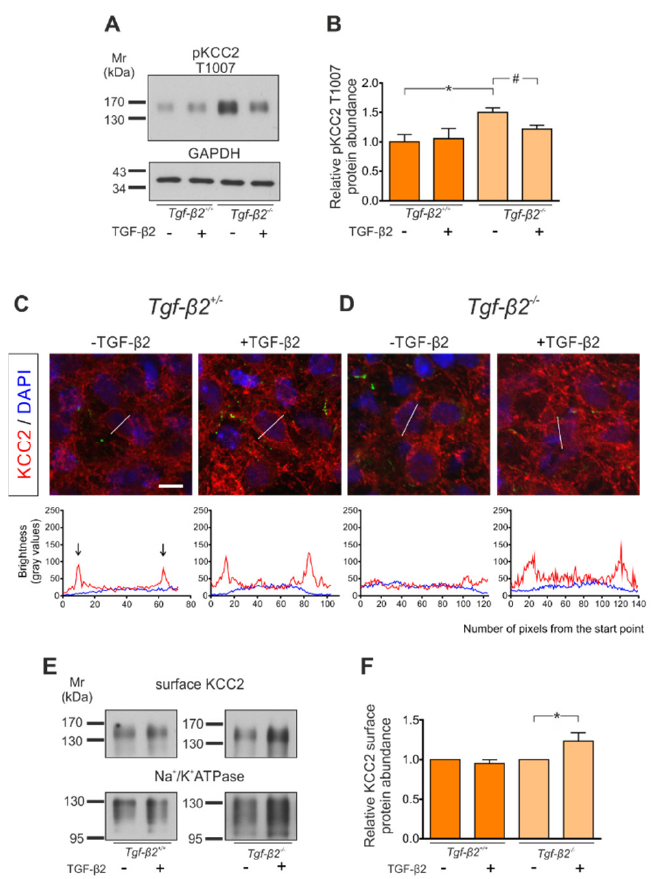
Figure 7. Application of exogenous recombinant TGF-β2 regulates phosphorylation and membrane expression of KCC2 in brainstem of Tgf-β2 −/− mutants. Acute slices from preBötC complex of E17.5–E18.5 from wildtype ( Tgf-β2 +/+ or Tgf-β2 +/− ) and Tgf-β2 −/− mutants were cultured in the presence or absence of recombinant human TGF-β2 (5 ng/mL) for 60 min. ( A , B ) Immunoblot analysis for phosphorylated (p)KCC2 at T1007 in homogenates from preBötC brainstem slices of Tgf-β2 +/+ and Tgf-β2 −/− mutant mice ( B ); * p < 0.05 for significant increase and # p < 0.05 for significant decrease after densitometric analysis of the signal ratio pT1007: GAPDH and two-tailed unpaired Student’s t -test, n = 3 for Tgf-β2 +/+ and n = 4 for mutants. A total of 10 µg protein were loaded per lane. Data are shown as mean ± SEM relative to the mean of untreated wt controls. ( C , D ) Fixed cryosections immunolabeled for KCC2 (red). Nuclei were labeled with DAPI (blue). Representative line scans (out of three animals/genotype) for KCC2 (red) and DAPI (blue) illustrate KCC2 labeling pattern from randomly selected neurons for each experimental condition. Scale bar: 30 µm. ( E , F ) Immunoblot analysis following biotinylation of surface proteins of acute brainstem slices containing the preBötC from Tgf-β2 +/+ and Tgf-β2 −/− mutant mice in the presence or absence of exogenous TGF-β2 (* p ≤ 0.05 for significant increase after densitometric analysis of the signal ratio KCC2: Na + /K + -ATPase and two-tailed unpaired Student’s t -test, n = 5/genotype; 50 µg protein was loaded per lane). The data are shown as mean ± SEM, relative to the untreated controls.